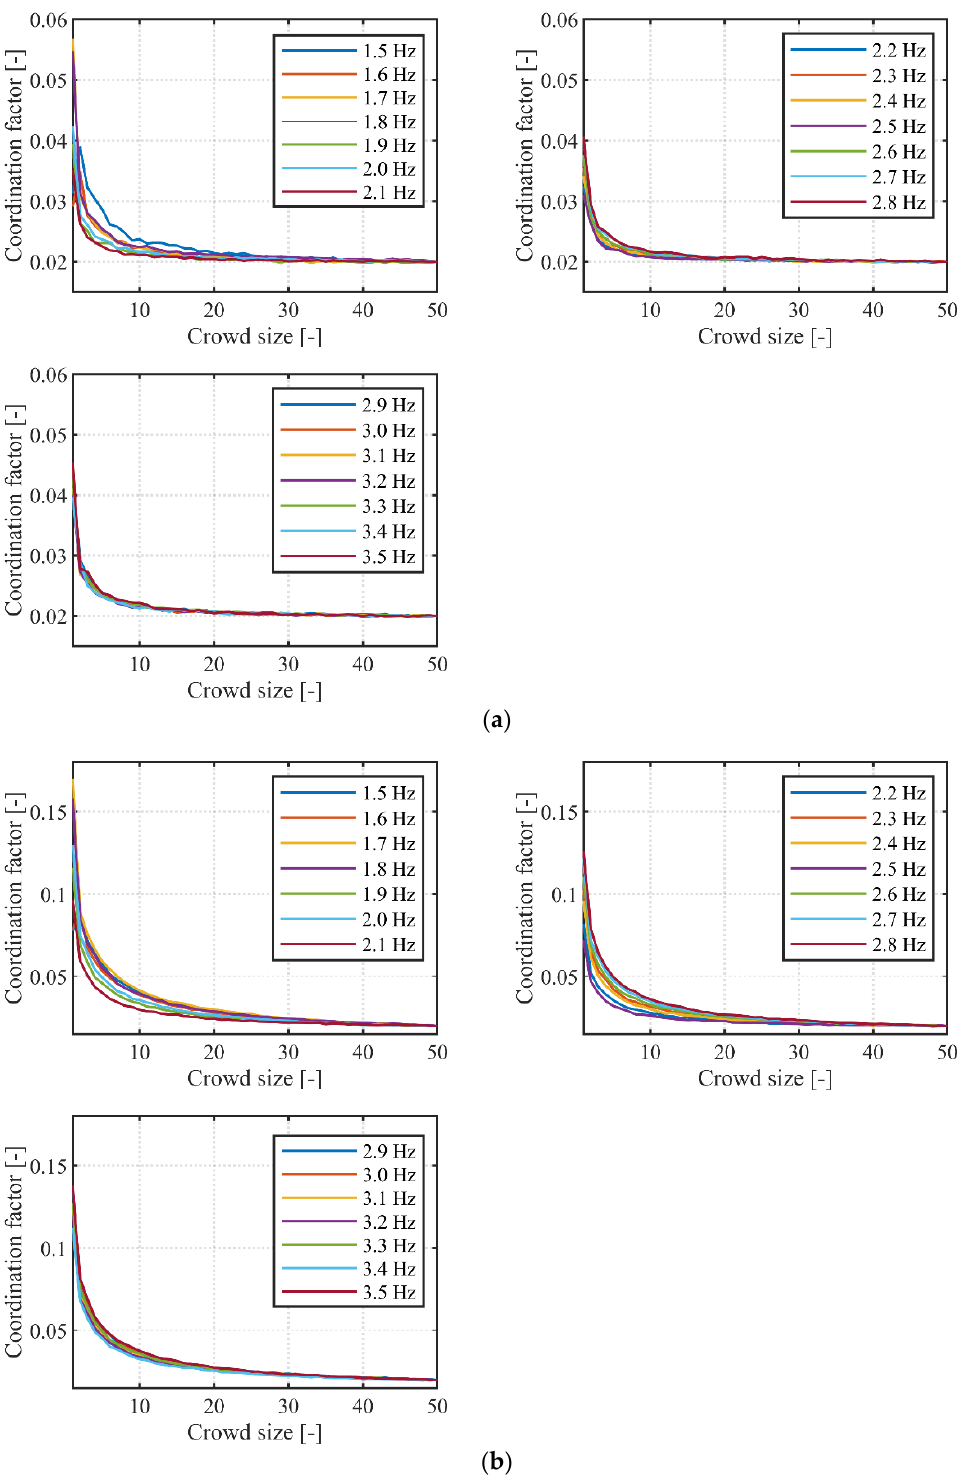
Figure 6. Relationship between coordination factor and crowd size. ( a ) Relationship for the first harmonic, ( b ) Relationship for the second